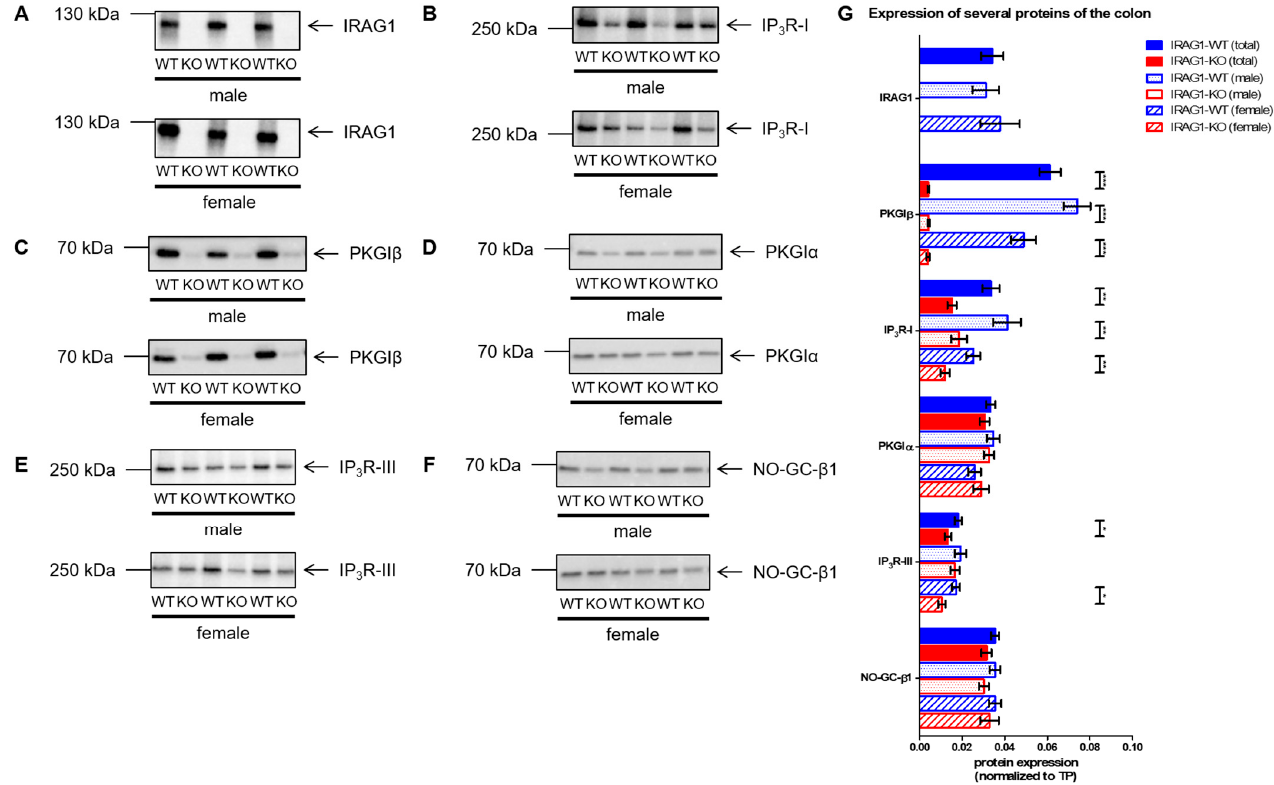
Figure 5. The expression of several cGMP/PKGI signaling proteins in colons from IRAG1-KO (KO) and IRAG1-WT (WT) mice. Protein expression of IRAG1-KO mice and their WT littermates (respective age: 15 weeks) were analyzed by western blot ( A – F ) and normalized to total protein (TP) for quantification ( G ). ( A ) Representative Western blot of IRAG1 in colons of male and female IRAG1-WT (total: n = 18; male: n = 10; female: n = 8) showed no differences between the sexes and no IRAG1 protein was found in IRAG1-KO mice (total: n = 22; male: n = 11; female: n = 11). ( B ) Western blot of IP 3 R-I showed a significant decrease in its expression in IRAG1-KO mice (total: n = 22; male: n = 11; female: n = 11) compared to WT littermates (total: n = 21; male: n = 11; female: n = 10). ( C ) The tremendous reduction of PKGI β protein in IRAG1-KO mice (total: n = 22; male: n = 11; female: n = 11) compared to IRAG1-WT mice (total: n = 24; male: n = 12; female: n = 12). ( D ) PKGI α expression was not altered between IRAG1-KO (total: n = 20; male: n = 10; female: n = 10) and IRAG1-WT mice (total: n = 22; male: n = 11; female: n = 11). ( E ) Reduced IP 3 R-III expression in IRAG1-KO mice (total: n = 21; male: n = 10; female: n = 11) in relation to IRAG1-WT mice (total: n = 17; male: n = 9; female: n = 8). ( F ) No altered NO-GC- β 1 expression between IRAG1-KO (total: n = 22; male: n = 11; female: n = 11) and IRAG1-WT mice (total: n = 23; male: n = 12; female: n = 11). ( G ) Statistical analysis of the expression of investigated proteins ( A – F ). The mean ± SEM is shown in the graphs, and significant differences are shown by (*) ( p < 0.05), (**) ( p < 0.01) and (***) ( p < 0.001). Images of total protein (TP) were shown in Figure